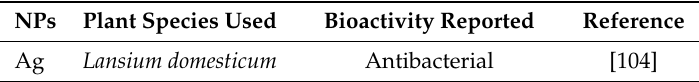
Table 2. Bioactivities of green-synthesized